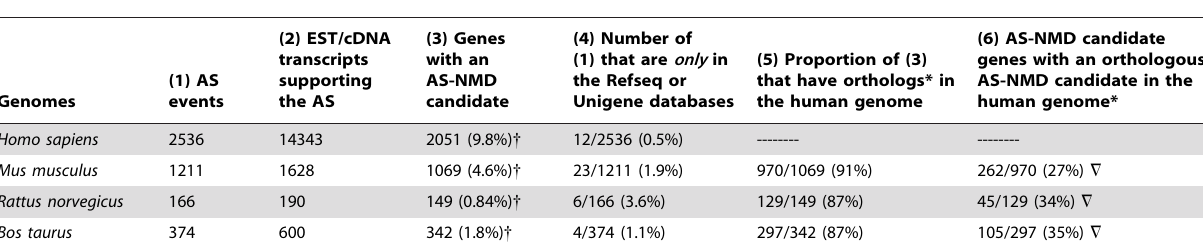
Table 1. Summary of the AS-NMD candidates.